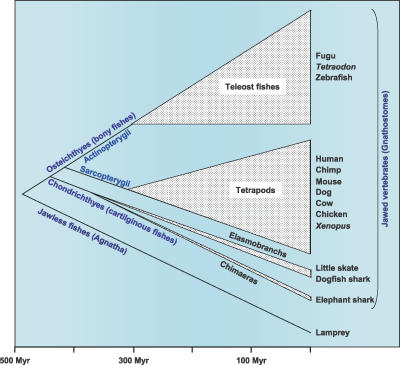
Phylogenetic Tree of VertebratesThe vertical axis represents the abundance of extant species in each of the groups. Names of representative member(s) of each of the lineages are given. The extant Actinopterygii (ray-finned fishes) include Cladistia (e.g., bichir, reedfish), Chondrostei (e.g., sturgeons, paddlefish), Ginglymodi (gars), Amiiformes (bowfin), and Teleostei (e.g., fugu, zebrafish); Sarcopterygii (lobe-finned fishes) include coelacanths, lungfish, and tetrapods (amphibians, birds, reptiles, mammals). Among these, only the teleost and tetrapod branches are shown. The divergence times shown are the minimum divergence times estimated based on fossil records. Agnatha-Gnathostomes, 477 My [69]; Chondrichthyes-Osteichthyes, 450 My [17]; elasmobranchs-chimaeras, 374 My [19]; tetrapods and teleost fishes, 416 My [3,4]. Note that these divergence times are more recent than the molecular sequence–based estimates (e.g., Kumar and Hedges [70]: Agnatha-Gnathostomes, 564 My; Chondrichthyes-Osteichthyes, 528 My; tetrapods and teleost fishes, 450 My).